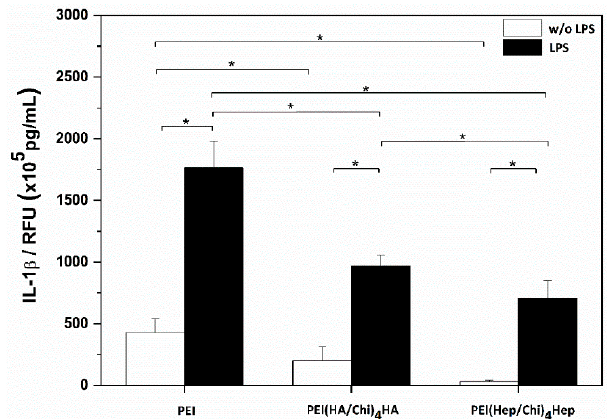
Figure 7. IL-1 β release from macrophages after 24 h incubation in absence (white bars) and presence (black bars) of lipopolysaccharide (LPS) on poly (ethylene imine) (PEI) and terminal layers of PEMs composed of either hyaluronic acid (HA) or heparin (Hep) as polyanions and chitosan (Chi) as polycation abbreviated as (PEI(HA/Chi) 4 HA and PEI(Hep/Chi) 4 Hep), respectively. Data represent means ± SD, n = 6, * p ≤ 0.05.